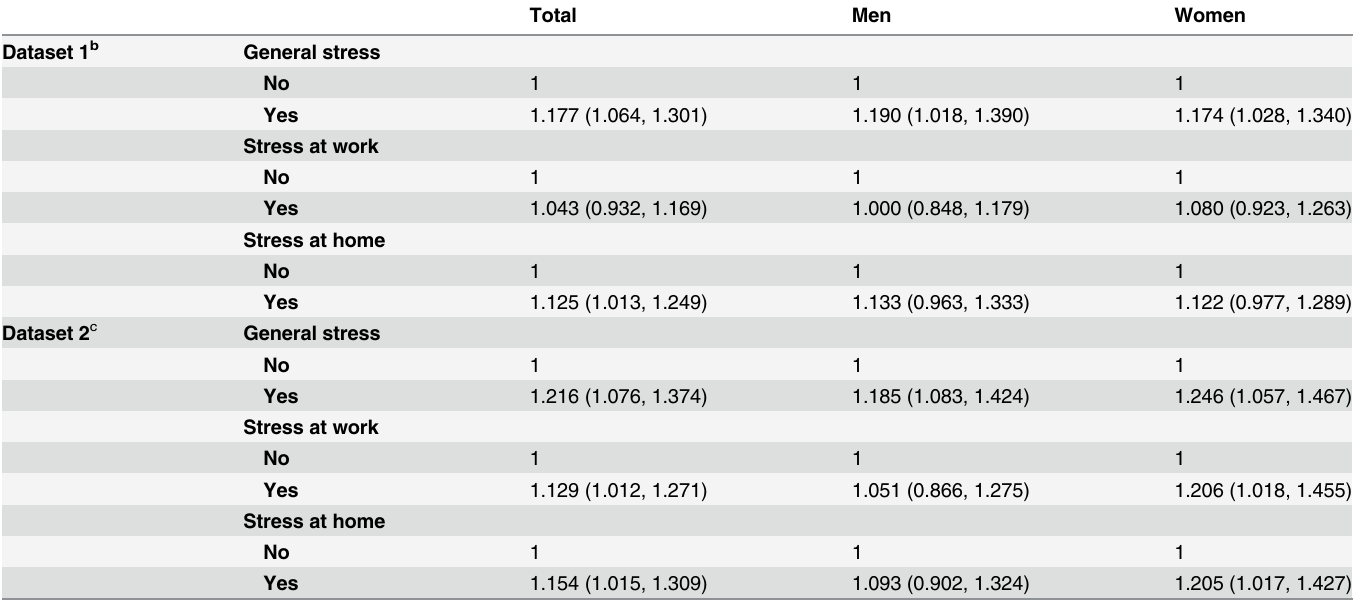
Table 4. The results of the sensitivity analysis for different datasets (odds ratios a